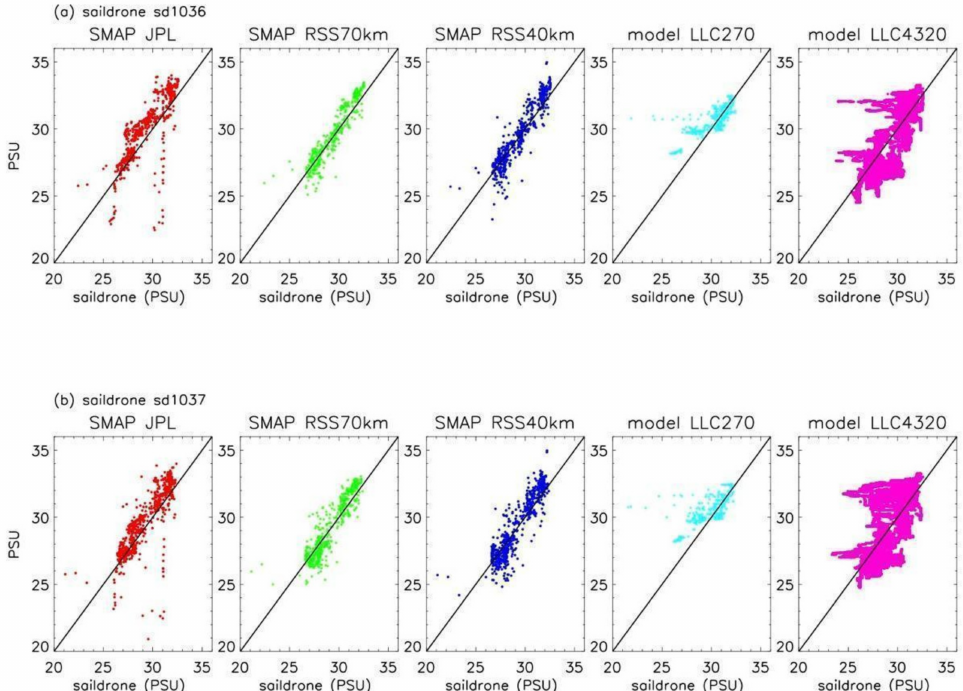
Figure 4. Scatterplot of salinity measured by the RBR sensor on ( a ) Saildrone 1036 and ( b ) Saildrone 1037 (average of all Saildrone measurements corresponding to the same satellite/model collocation) and collocated SMAP SSS and model outputs. Same color code is used for each product as in the time series of Figure